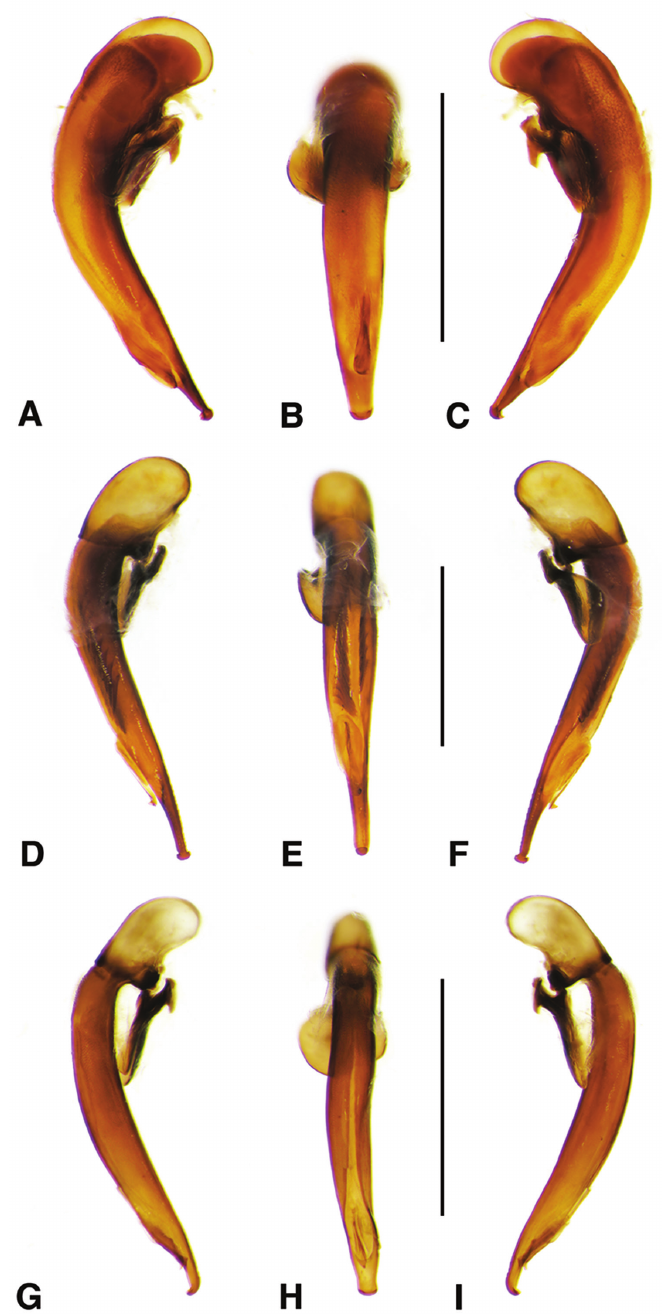
Figure 19. Digital images of male genitalia of Selenophorus latior species group. A, D, G right lateral aspect B, E, H dorsal aspect C, F, I left lateral aspect A–C S. barbadensis Ball & Shpeley D–F S. latior Darlington G–I S. solitarius Darlington. Scale bars 1